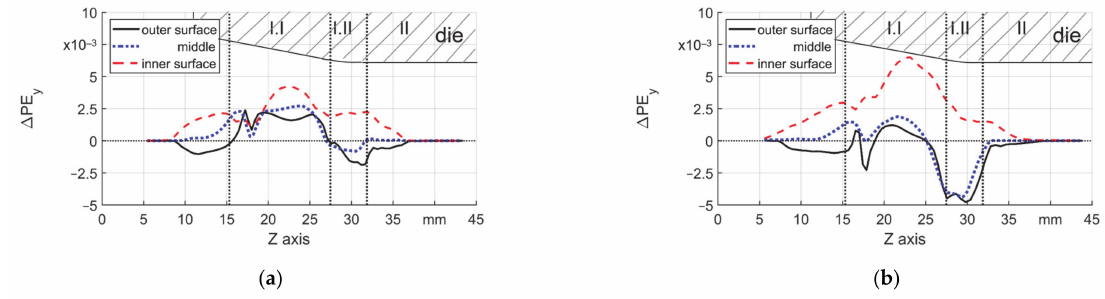
Figure 15. ∆ PE y on three layers, µ = 0.18, ( a ) s 0 = 3 mm and ( b ) s 0 = 5 mm.